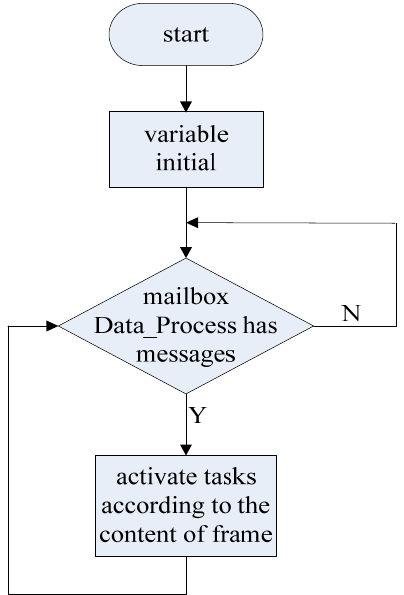
Figure 20. The flow chart of the data process